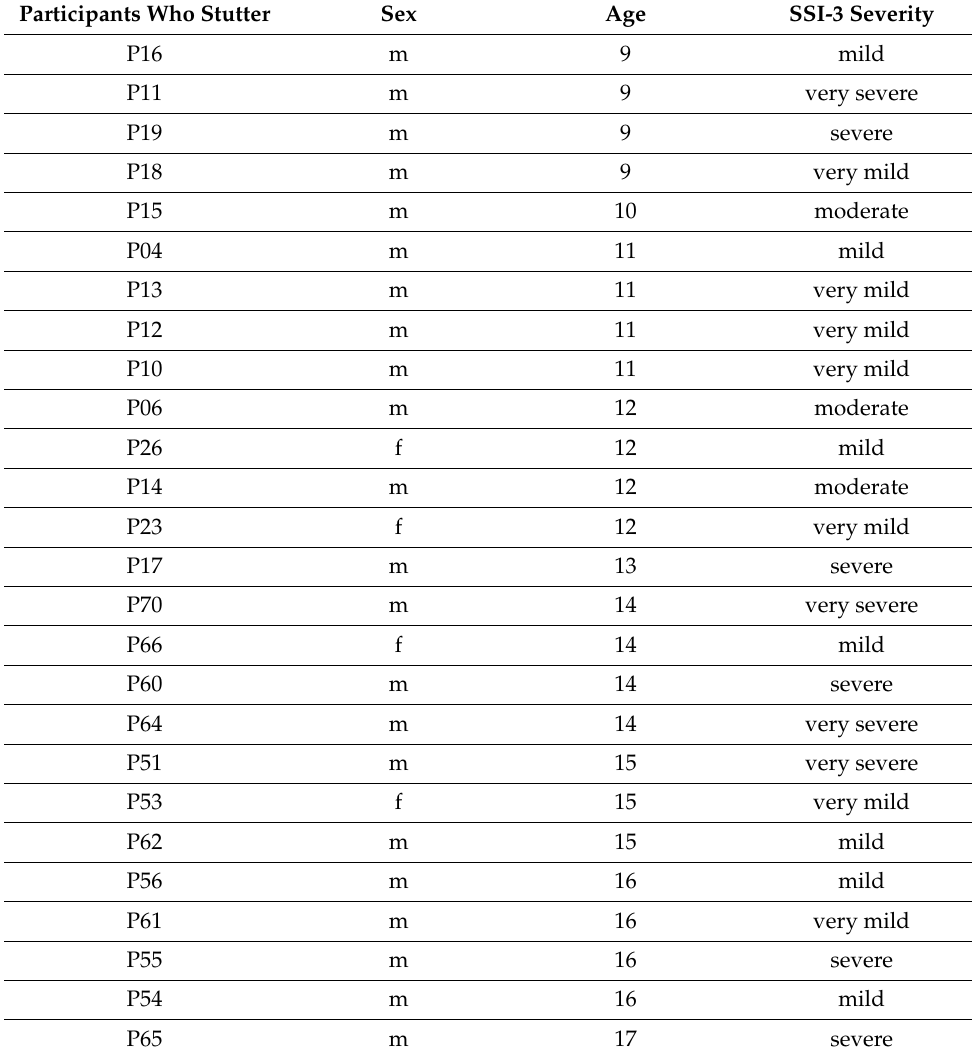
Table 1. Individual participant information at recording time. Children who stutter (CWS, upper part) and adolescents who stutter (AWS, lower